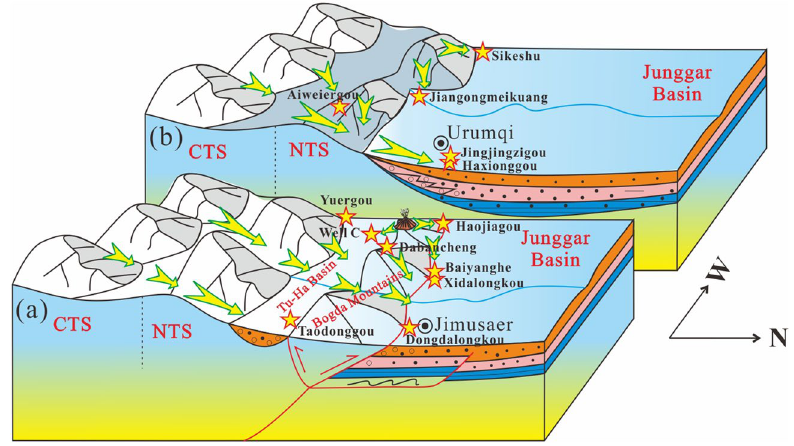
Figure 10. Schematic 3D diagram demonstrating the source-to-sink system of the (a) eastern part (Bogda mountains area) and (b) western part (front of the NTS) of the southern Junggar Basin in the Middle–Late Triassic. NTS North Tianshan, CTS Central